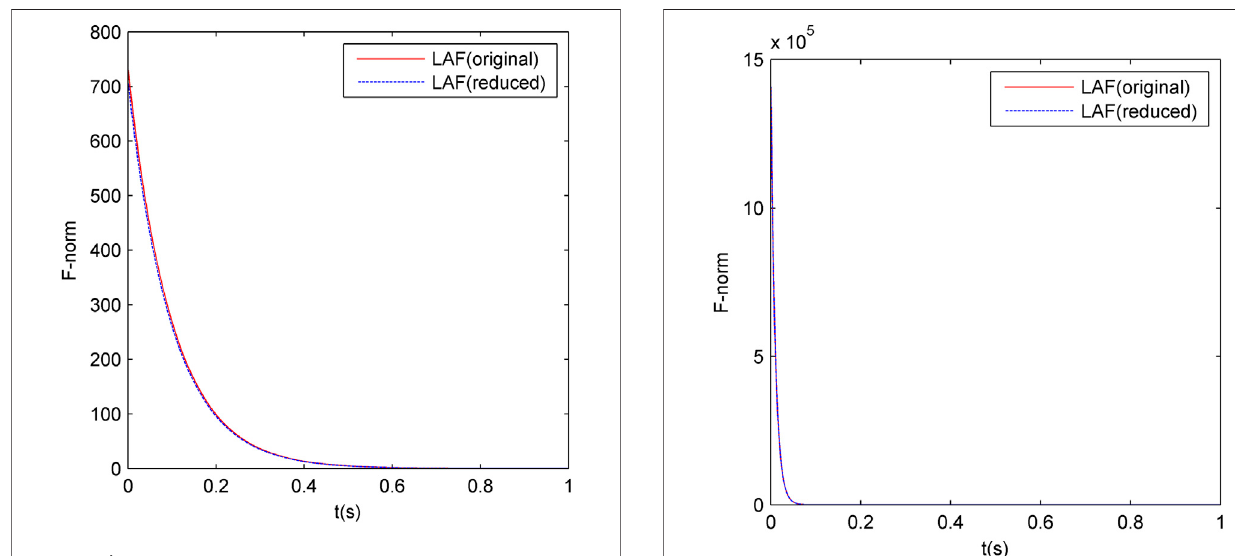
FIGURE 6 | Comparison of the convergence between the original-order and the reduced-order ZNN models under Example 4.